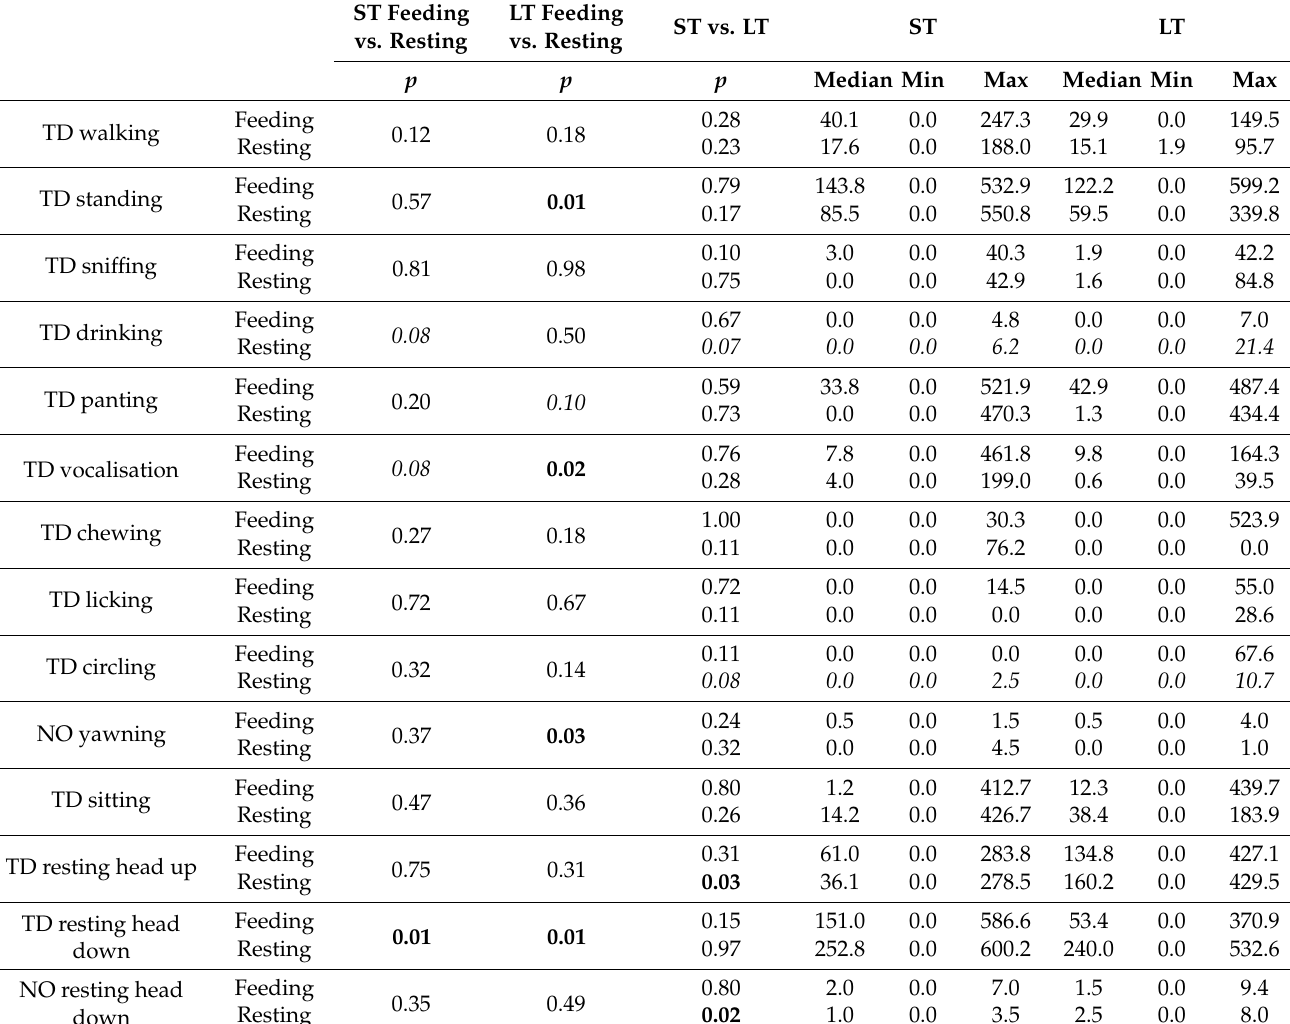
Table 5. Analysis of the video recordings comparison between groups. TD = total duration, NO = number of occurrences per 10 min, corrected for the time visible. Significant results are in bold and trends are in